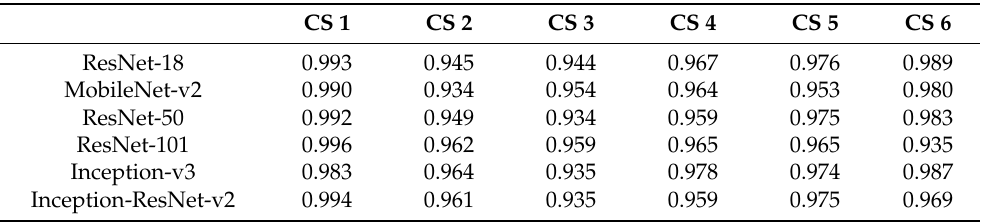
Figure 3. The ROC curves of the CNN-based deep learning models for determination of CVM stages. ( a ) ResNet18; ( b ) MobileNet-v2; ( c ) ResNet-50; ( d ) ResNet-101; ( e ) Inception-v3; ( f ) Inception-ResNet-v2. Table 4. CVM stage classification performance by the AUC corresponding to the CNN-based deep learning models.